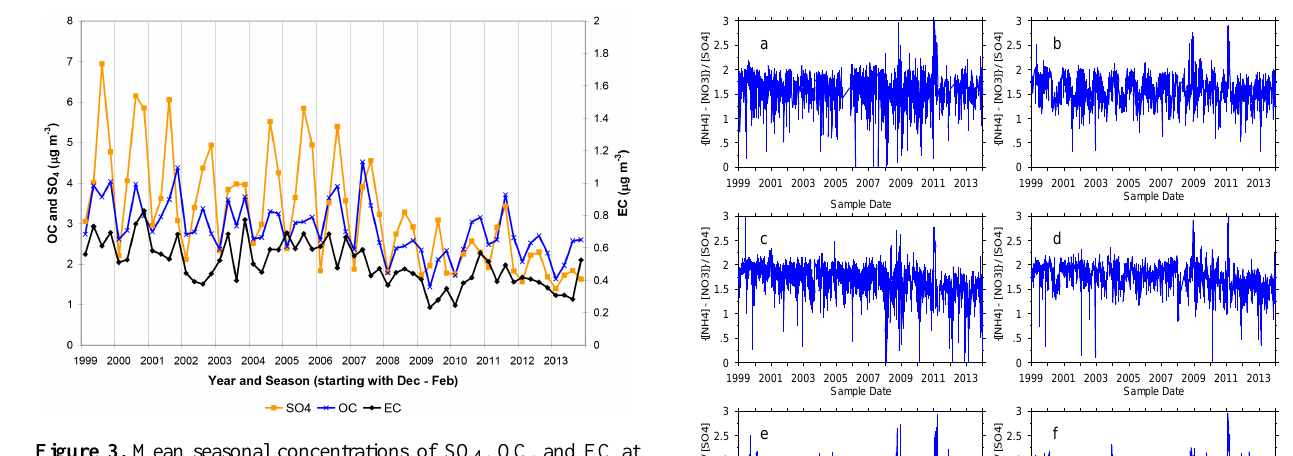
Figure 3. Mean seasonal concentrations of SO 4 , OC, and EC at CTR. Seasons are by calendar month (1) December–February, (2) March–May, (3) June–August, (4) September–November. Vertical divisions are calendar year between Q4 and Q1. OC and EC tend to track one another and the trends are downward at approximately the same annual rate, while SO4 shows a sharper decrease until 2008. OC tends to have winter minima, but OC maxima vary between Q2 and Q4.